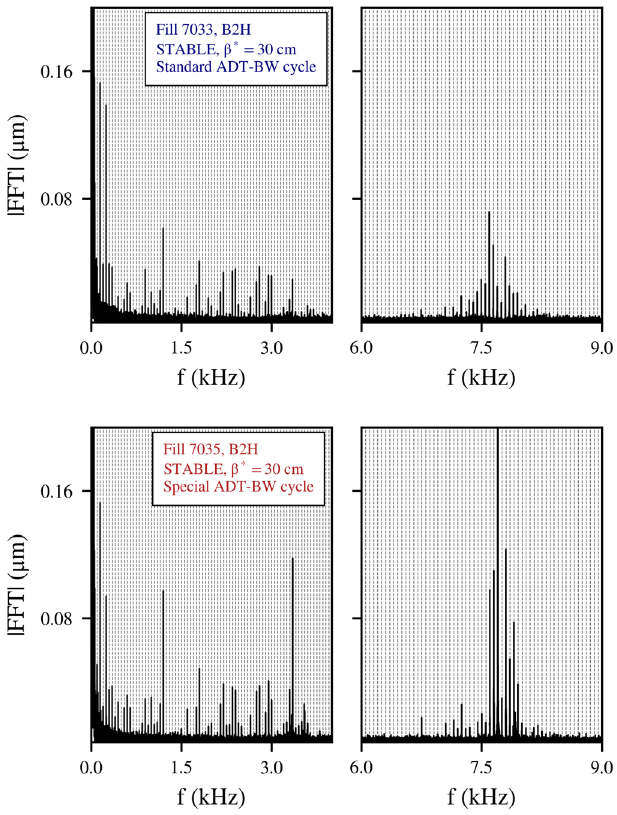
FIG. 19. The horizontal spectrum of Beam 2 at stable beams centered around the low (left) and high (right) frequency cluster for a fill with the standard (Fill 7033, top) and (b) extended (Fill 7035, bottom) ADT